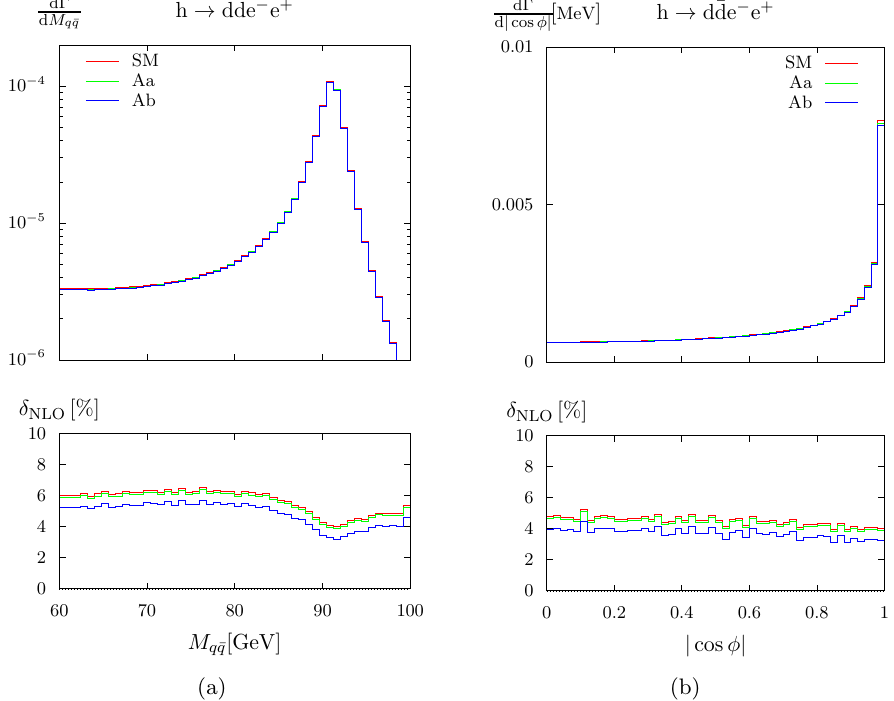
Figure 19 . Invariant-mass (a) and angular distributions (b) of the charged-current semi-leptonic d(cid:22)de (cid:0) e + for the SM and the THDM benchmark scenarios Aa and Ab. The relative NLO decay h ! EW+QCD corrections to the distributions are plotted in the lower panels. In the upper row, all curves nearly coincide, while in the lower row, the SM prediction is close to the THDM prediction of scenario